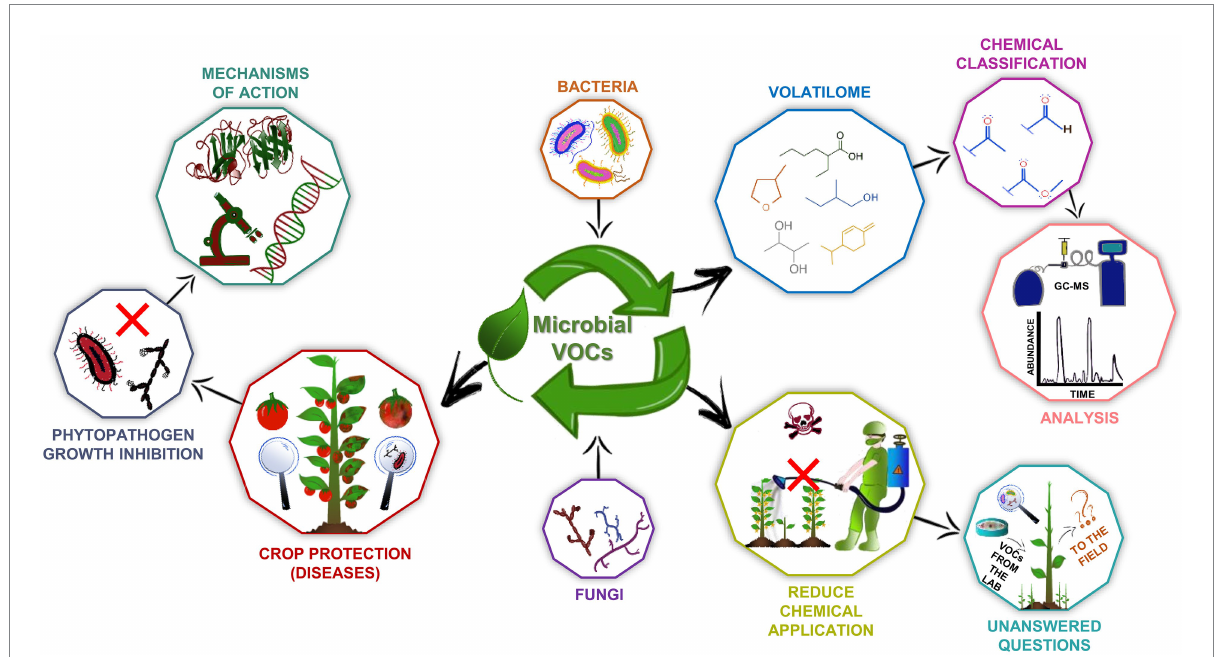
FIGURE 1 Biotechnological aspects of microbial volatile organic compounds (VOCs). They are produced by fungi and bacteria and belong to diverse chemical classes that can be identified by several techniques, such as gas chromatography coupled to mass spectrometry (GC–MS). These molecules have great biotechnology potential as plant growth promoters and phytopathogen inhibitors, and many studies have demonstrated such effects in vitro and in vivo . Therefore, it has become possible to develop bioproducts to be applied in the field and thereby reduce the use of agrochemicals. Nevertheless, some questions about the use of microbial VOCs as biotechnological products need to be answered. Moreover, although several beneficial microorganisms and bioactive VOCs have been described, the molecular mechanisms of action of these compounds remain poorly